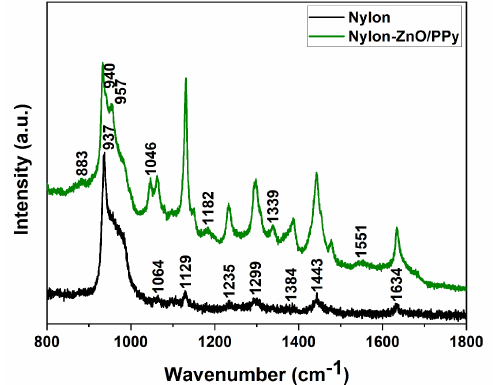
Figure 4. Raman spectra of as spun nanofibers and PPy/ZnO coated meshes.